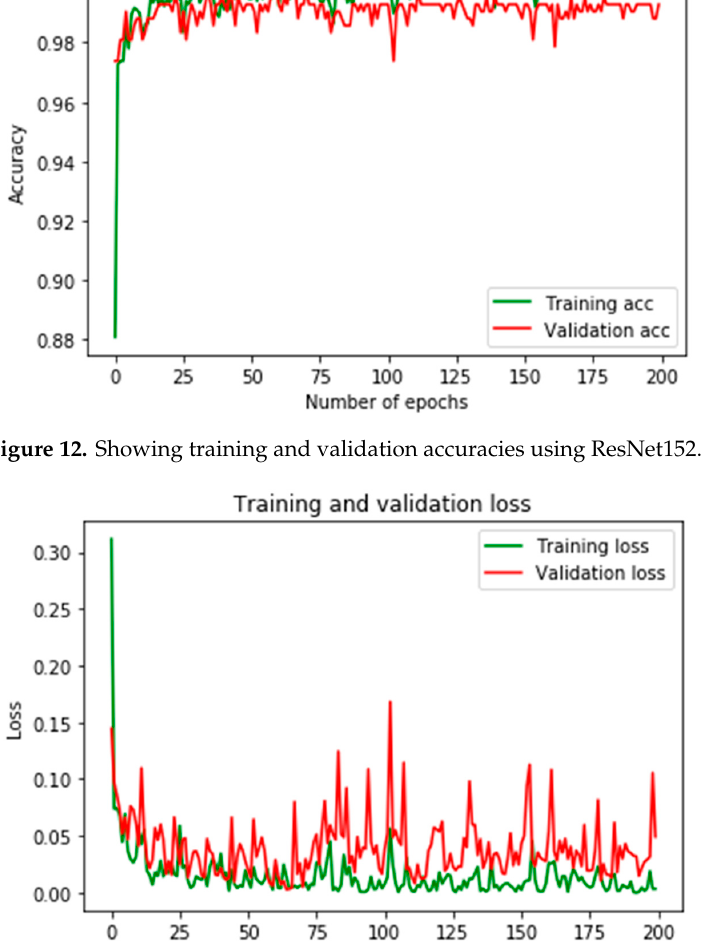
Figure 13. Showing training and validation losses using ResNet152 .